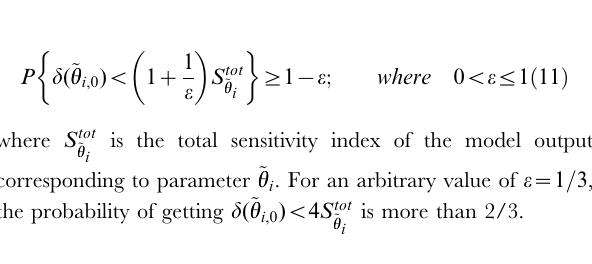
Figure 9. MCV model fit to individual patient data obtained from Riley Hospital for Children. Solid dots indicate D MCV of individual patient undergoing 6-MP treatment and solid lines represent the model fit. The estimated patient-specific parameters are provided in Table 5.